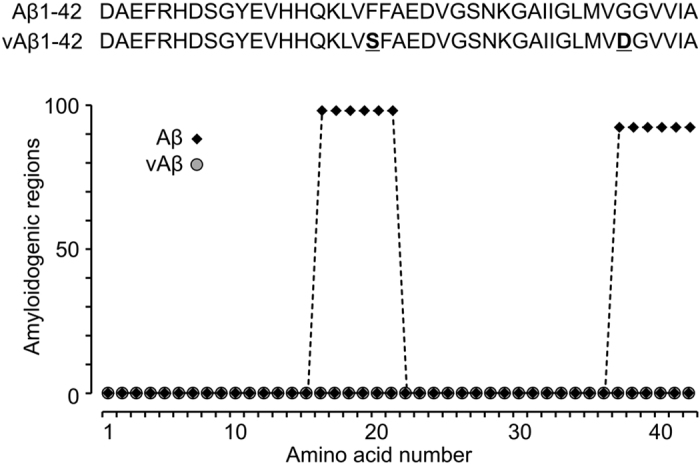
The graph produced using WALTZ19 shows two peaks that indicate two amyloidogenic regions (residues 16–21 and residues 37–42) in Aβ1-42 compared to the trace for vAβ1-42 peptide design showing abolition of the amyloidogenic regions.